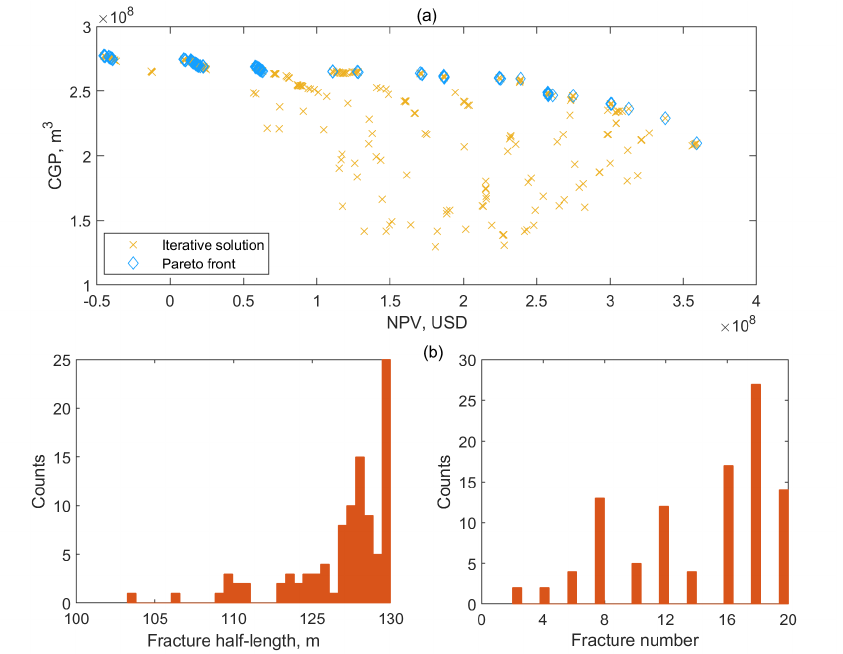
Figure 14. Illustration of the Pareto fronts at the final generation and historical solutions ( NPV , CGP ) over all realizations. ( a ) The Pareto-front solutions at the final generation and the ensemble fronts; ( b ) statistic distributions of optimized hydraulic fracture